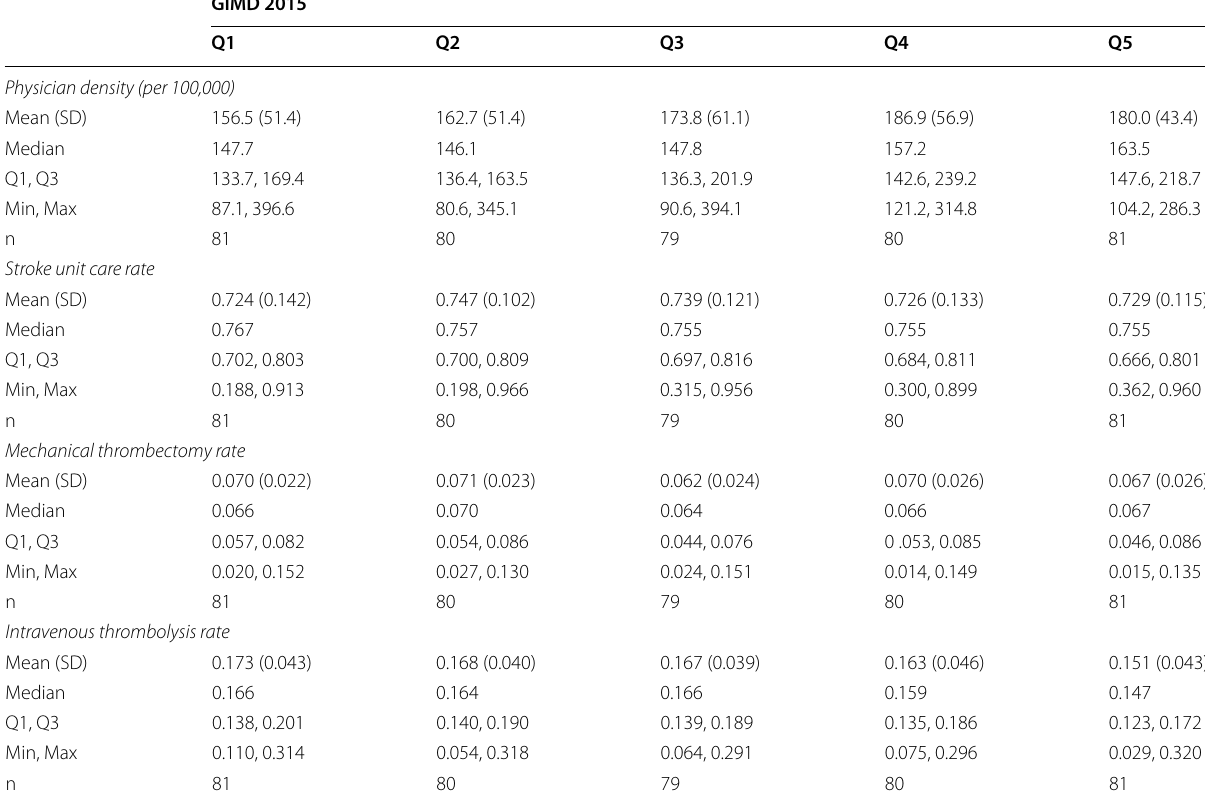
Table 3 Stroke care and treatment-related variables across GIMD 2015 quintiles (N